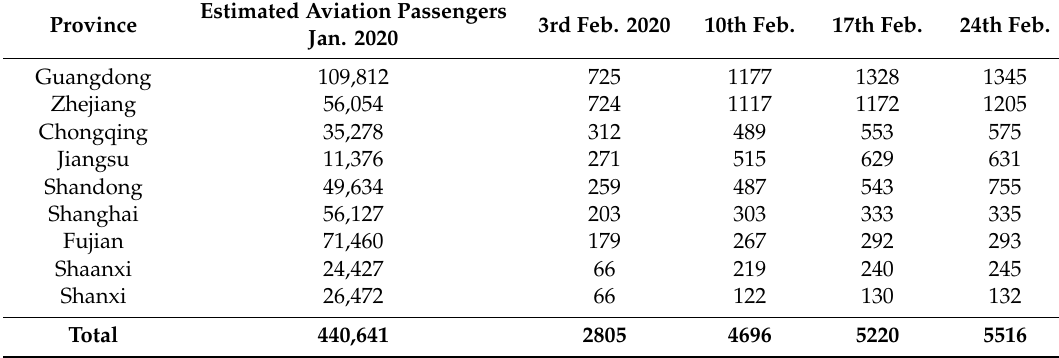
Table 3. Estimated passengers and number of reported cases, China (700–1000 km from Wuhan). Province